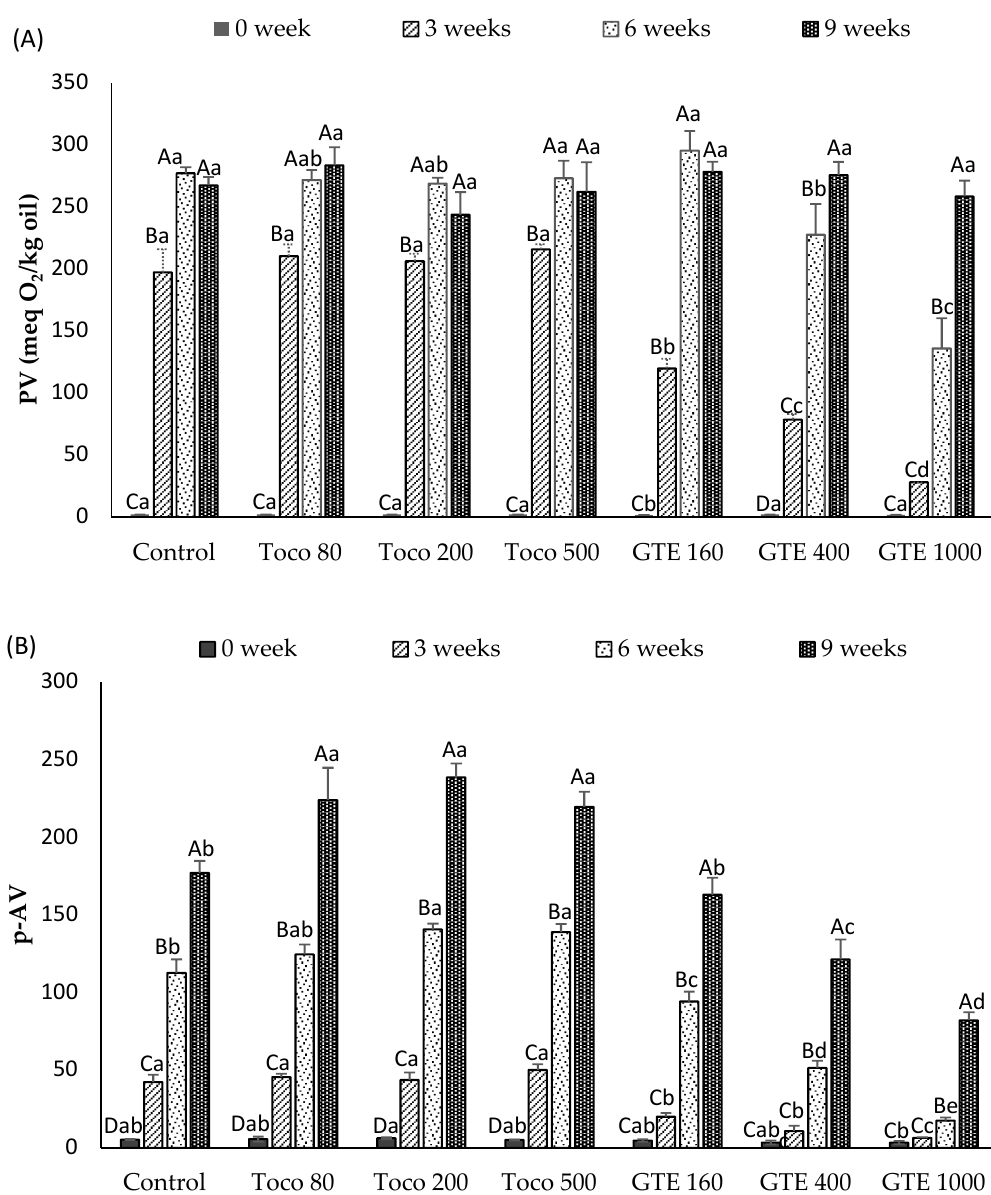
Figure 1. Peroxide value (PV) ( A ) and p -anisidine value ( p -AV) ( B ) of DHA-rich oil (DHAO) with or without antioxidant during an oven storage test at 30 °C. Values are mean ± SD (n = 3); Different capital letters (A–D) indicate significant differences ( p ≤ 0.05) during storage within a sample; different lower-case letters (a–e) among samples indicate a significant difference ( p ≤ 0.05) at a specific storage time. Control = DHA-rich oil without added antioxidant; Toco80, Toco200 and Toco500 = DHA-rich oil supplemented with 80 ppm, 200 ppm and 500 ppm of α-tocopherol, respectively; GTE160, GTE400, GTE1000 = DHA-rich oil supplemented with 160 ppm, 400 ppm and 1000 ppm of green tea extract, respectively.